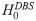
Response of the reduced model in the case of periodic stimulation patterns.The graphs (A-D) show the β-Power, root mean square value of the activity and power spectra computed from the synaptic current I1 corresponding to the neural population N1, when a periodic stimulation pattern configured with a pulse width of δ = 0.5 ms was applied to the population N2. (A) β-Power and the root mean square value of the activity as a function of the stimulation amplitude H0DBS for a constant clinically relevant stimulation frequency of fDBS = 130 Hz. (B) β-Power and the root mean square value of the activity as a function of the stimulation frequency fDBS, keeping the stimulation amplitude unchanged at H0DBS=10. The frequency for the period doubling bifurcation fd ∼30 Hz and the frequency for activity total suppression fs ∼220 Hz, are indicated with solid vertical lines in order to highlight the transition points between the three states of the system: (1) Null activity (fDBS > fs), (2) β-Power suppression (fd < fDBS < fs) and (3) Pathological β-Power (fDBS < fd). In the graphs (A) and (B) the β-Power has been normalized with respect to that obtained for the system in the oscillatory state without stimulation (H0DBS=0). (C) Power spectrum obtained for the stimulation frequency configured at fDBS = 28 Hz < fd. In this case, the power spectral component in the β-band 10-20 Hz (dashed vertical lines), is produced by the period doubling induced by the stimulation frequency. The inset of the graphs show the resulting I1 signal which has a fundamental period given by the natural frequency of the system ω2π=13 Hz. (D) Power spectrum obtained for the stimulation frequency configured at fd < fDBS = 50 Hz < fs. In this case, the stimulation pattern produces the suppression of the oscillations in the β-band without nullifying the activity A1. Thus, the period of the I1 signal (1/fDBS) is determined by the stimulation pattern (see the inset) and the resulting power spectral components correspond to the fundamental frequency of the stimulation fDBS and its harmonics.